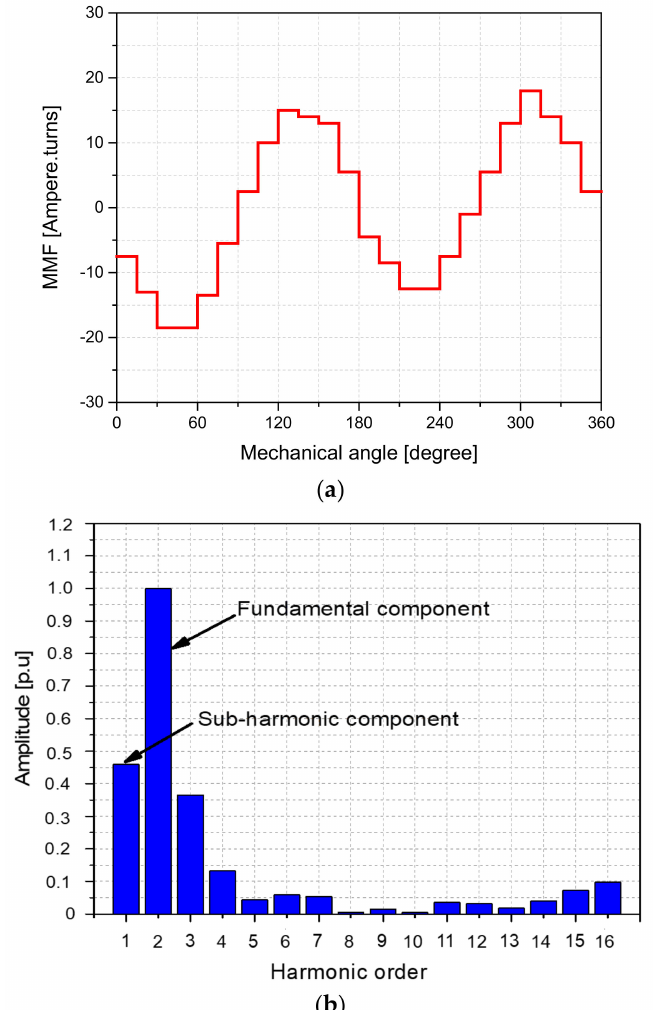
Figure 7. For the proposed BL-WRSM topology based on sub-harmonic field-excitation technique ( a ) MMF plot for 24-slot armature winding, and ( b ) THD of the MMF plot.